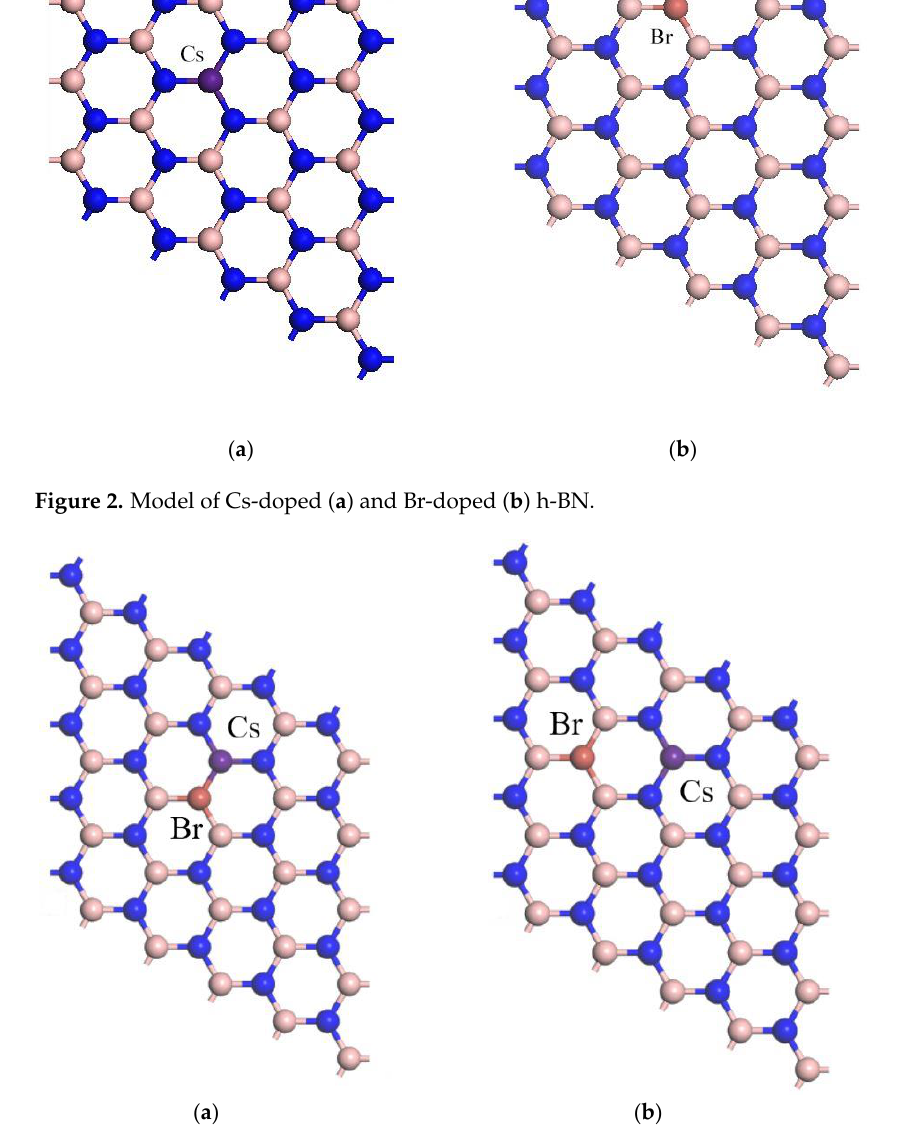
Figure 3. Model of Cs-Br ( a , b ) co-doped h-BN.